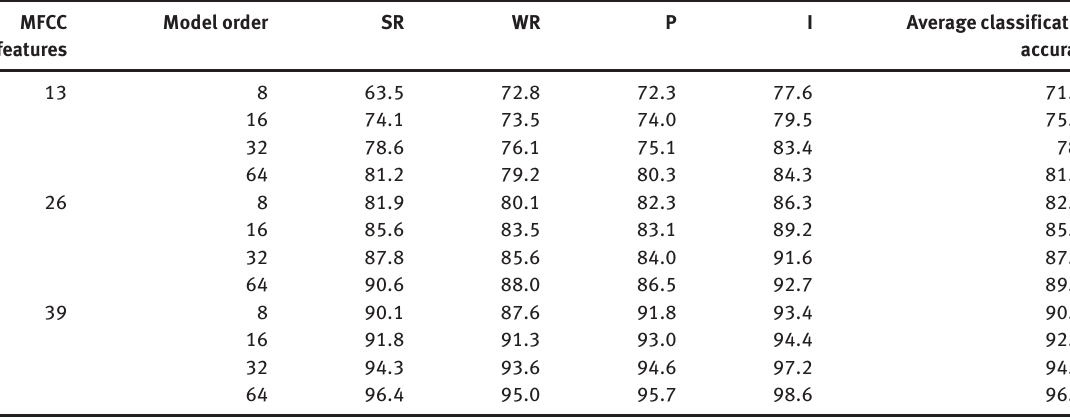
Table 3: GMM Classification Performance for Different Parameters and Model Order.